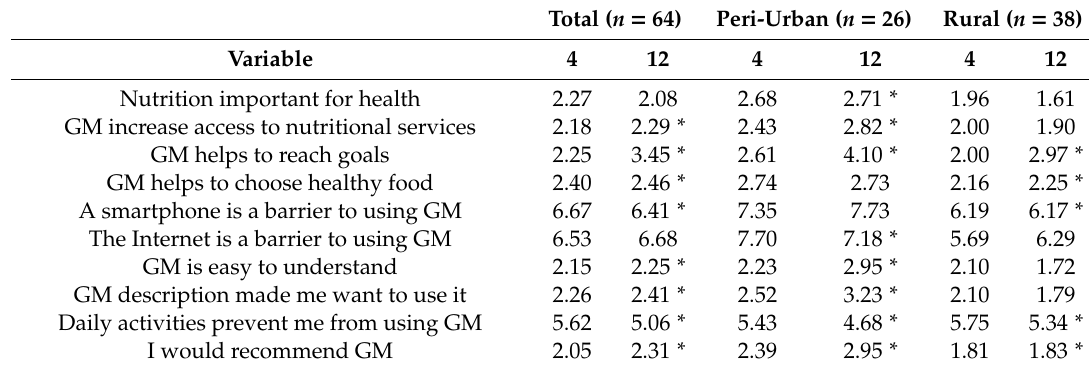
Table 3. Attitude and behaviors of the population toward Good